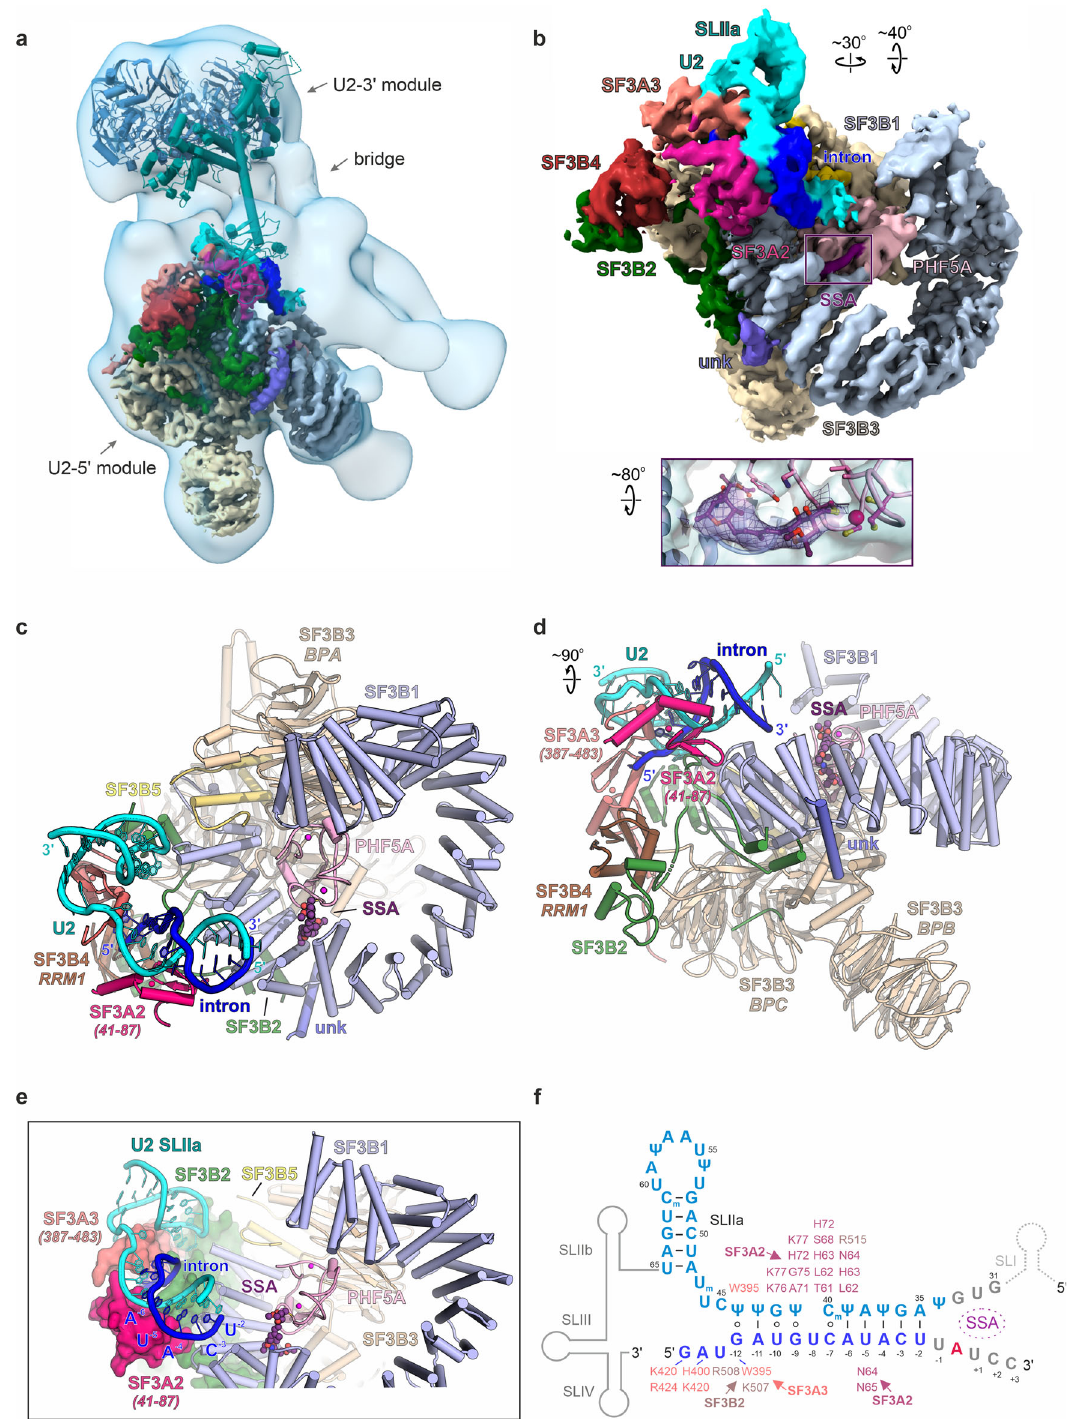
Fig. 1 Cryo-EM structure of human A3 ′ prespliceosome-like complex arrested with SSA. a Overall cryo-EM density map of the U2 snRNP module of the A3 ′ prespliceosome. The density maps of the U2 5 ′ module and U2 snRNP are superimposed. The subunits are color-coded as in b . The proteins of the U2 3 ′ module and associated SF3A domains are docked as a rigid body and depicted in cartoon representation. b Cryo-EM density map of the U2 5 ′ module resolved at 3.1 Å resolution. The inset shows the density element observed in SF3B ’ s hinged pocket and corresponds to the SSA ligand. c , d Overall organization of the U2 5 ′ module in two orientations. e Structure of the U2 5 ′ module, emphasizing the U2/intron duplex relative to the surface of contacting subunits and the SSA. f Organization of the U2/intron structure within the A3 ′ -SSA complex. Proteins and residues that interact with the U2/ intron duplex are labeled. Methylated bases are marked with subscript “ m ” , and Ψ denotes pseudouridine. Except for a , all subunits are colored and labeled accordingly throughout the fi